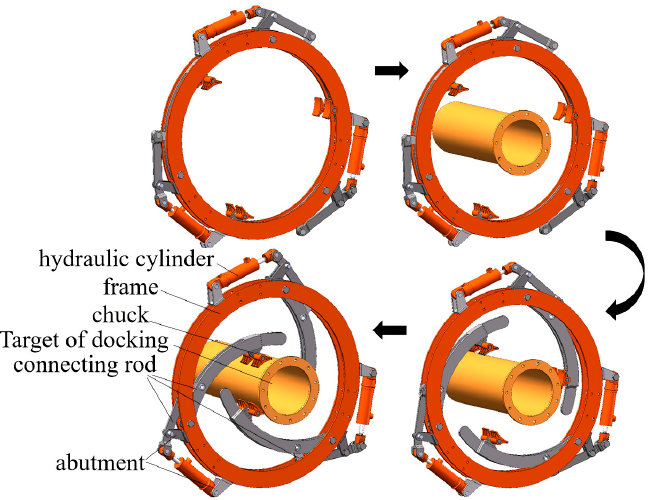
Figure 21. Working principle of the auxiliary docking device.